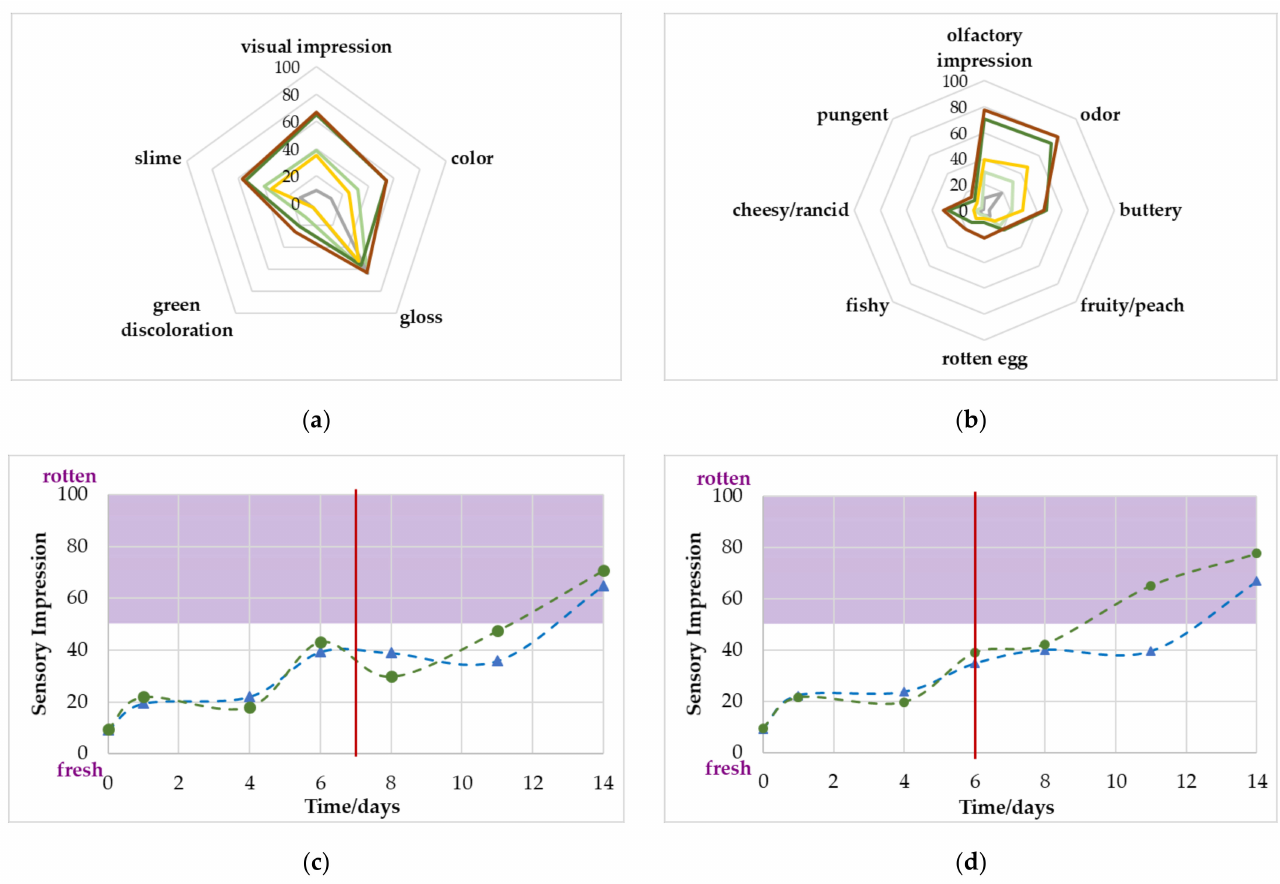
Figure 5. ( a , b ): Sensory evaluation of the poultry stored at 4 ◦ C by the panel with the chosen descriptors for ( a ) visual and ( b ) olfactory attributes on day 0 (grey line), after reaching the critical value of 10 7 CFU/g (70% O 2 /30% CO 2 : light green; 80% O 2 /20% CO 2 : yellow) and on day